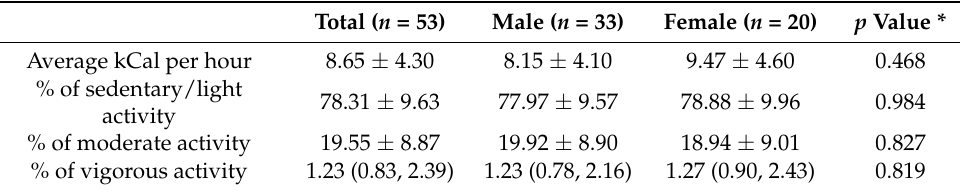
Table 3. Accelerometry